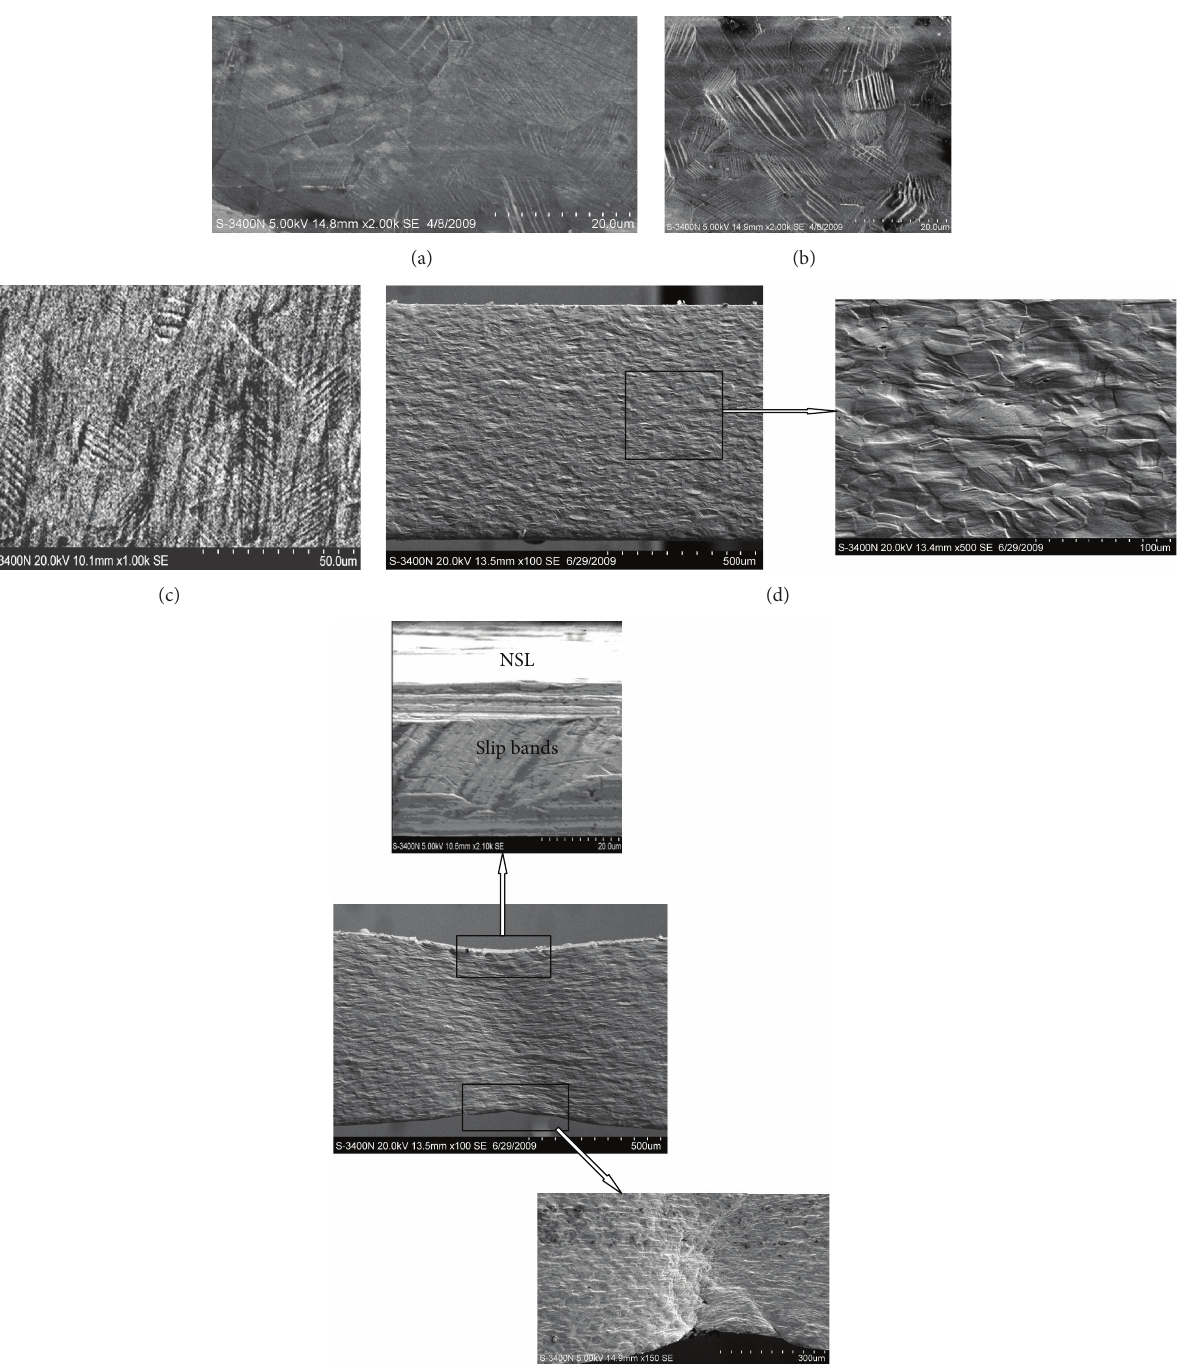
Figure 3: SEM images under different tensile stresses: (a) 380 MPa, (b) 460 MPa, (c) 550 MPa, (d) 630 MPa, and (e) 810MPa.